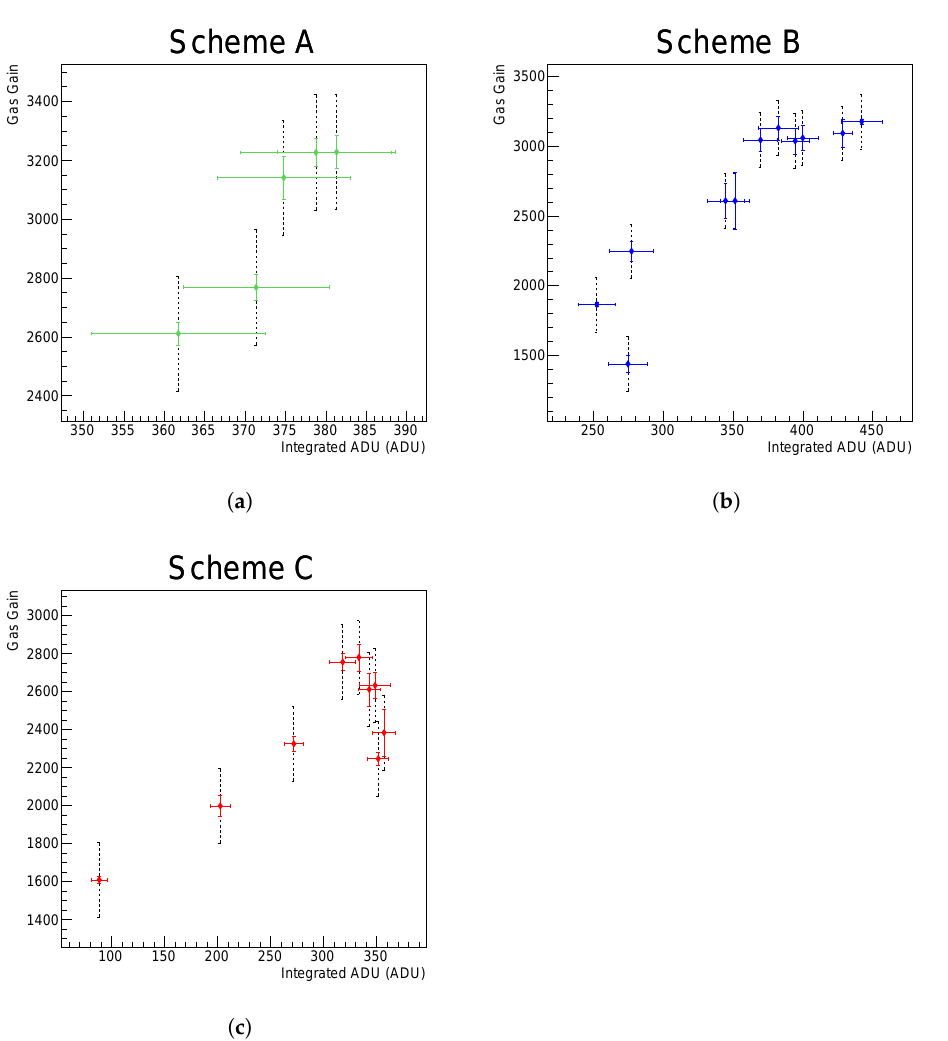
Figure 23. Measured light intensity (Integrated ADU) (Figure 15) plotted against the gas gain measured in the charge readout on anode 3 (Figure 22, right column) for Scheme A ( a ), Scheme B ( b ), and Scheme C ( c